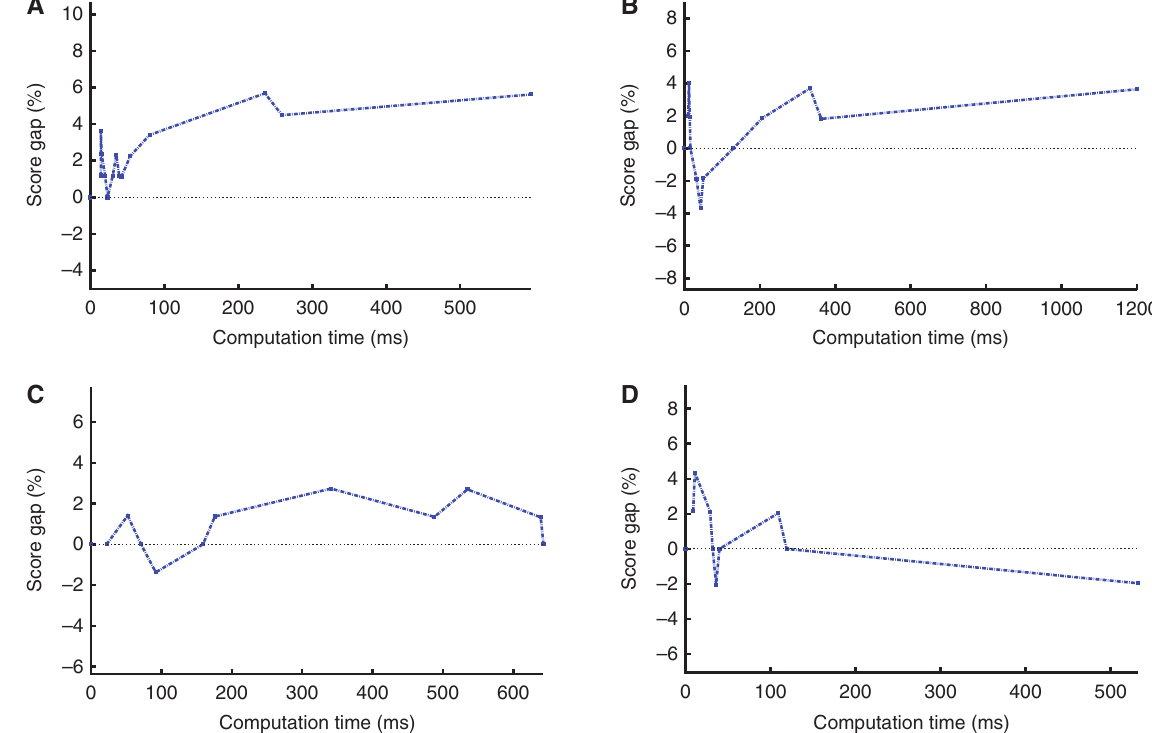
Figure 1: Patterns of Score Gap Evolution Over Time (Enhanced ILS vs . ILS). (A) enhILS superior all over the runtime; (B) enhILS superior over most of the runtime; (C) enhILS similar, better along the runtime; and (D) enhILS inferior, competitive along the